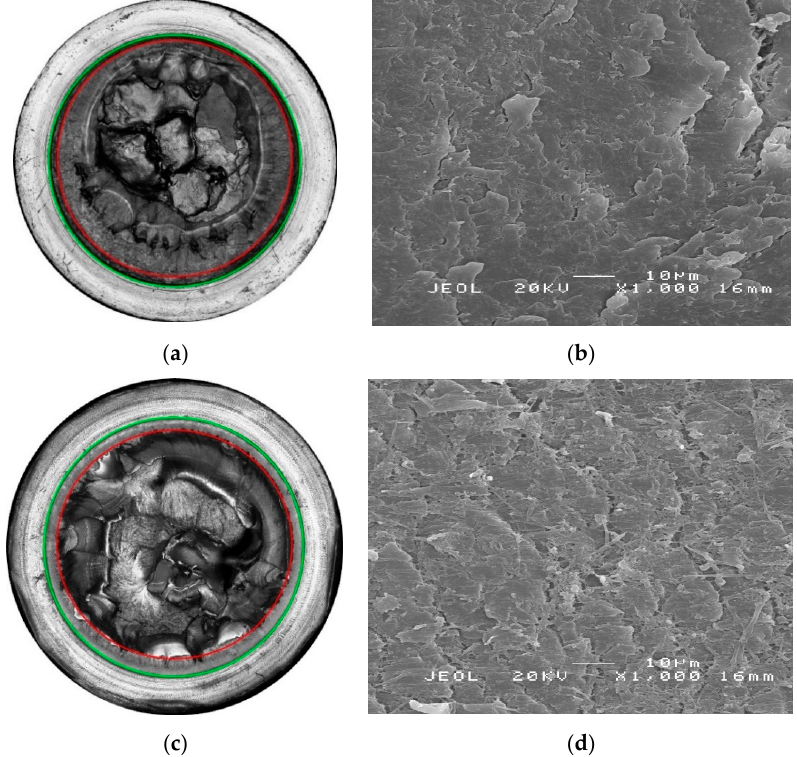
Figure 7. Surface with emphasized start (green circle) and end (red circle) of stable crack growth together with a detail of the stable crack growth region for ( a , b ) PP-R α and ( c , d ) PP-R β tested at 60 °C in non-chlorinated water with 0 mg/L free chlorine.